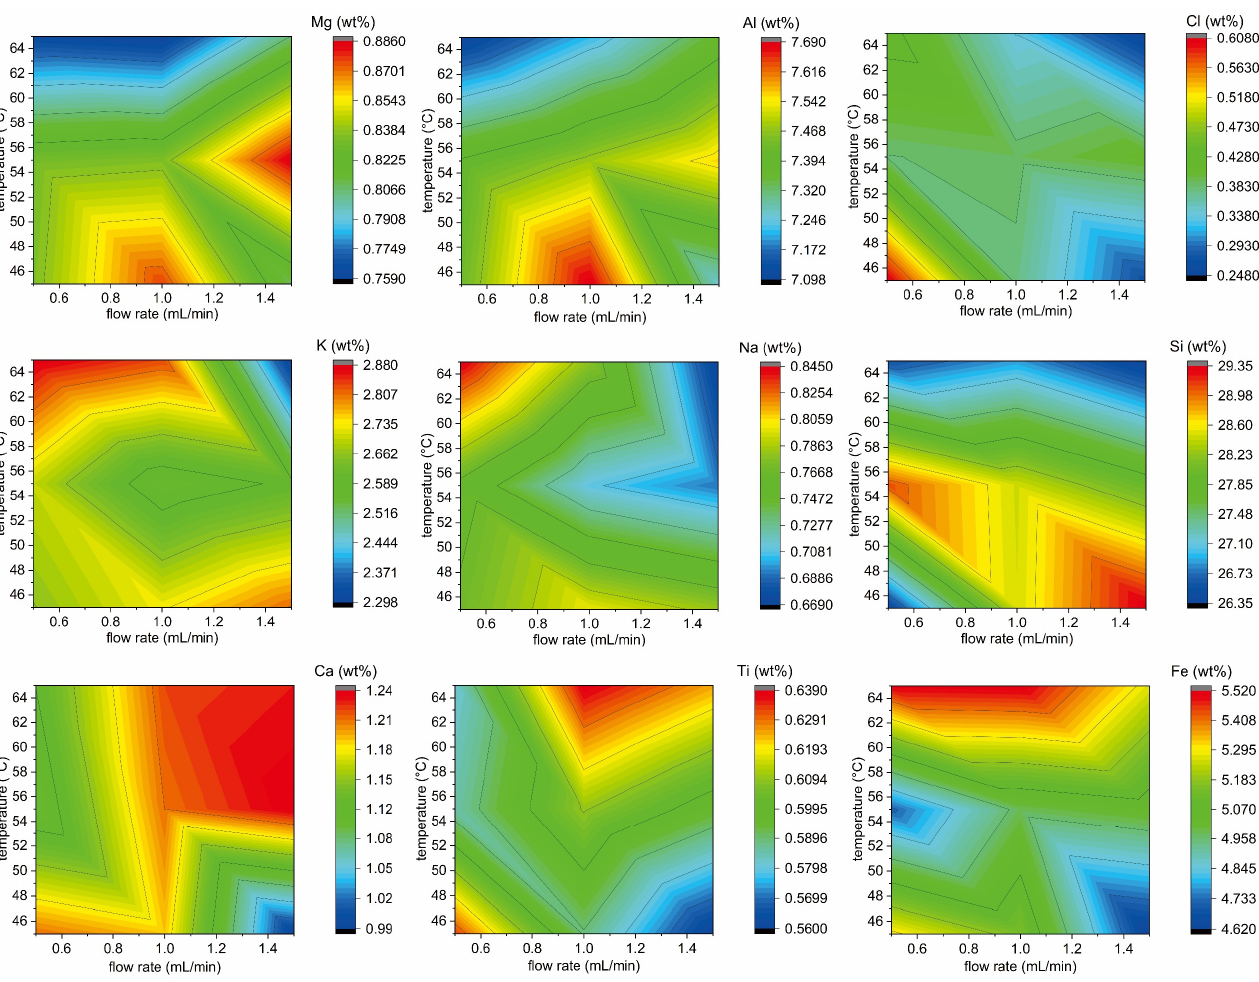
Figure 9. Contour plots of major elemental compositions of ground sandstone specimens after the displacement experiment under different temperature and flow conditions.